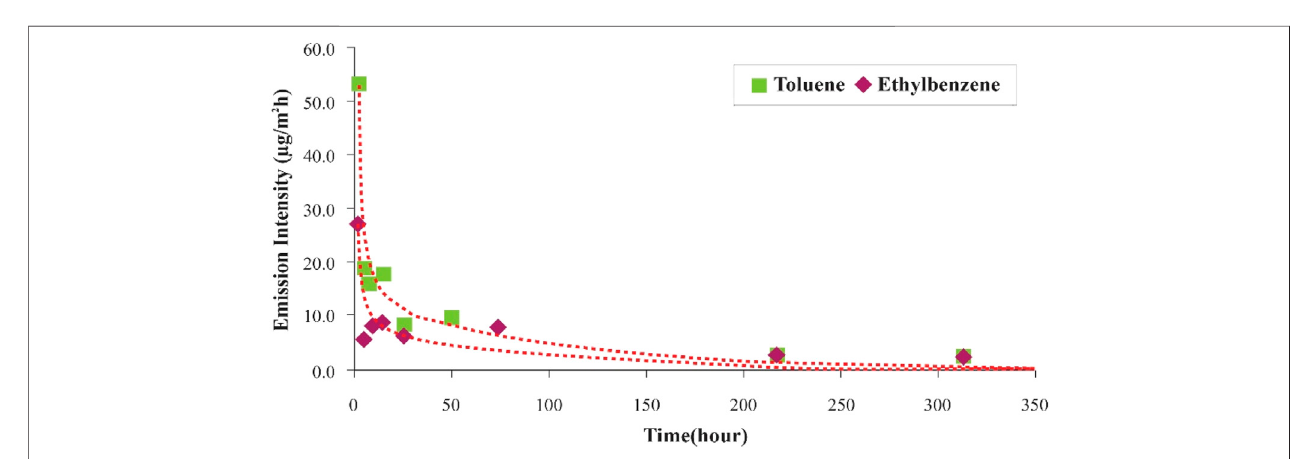
FIGURE 5 | Emission pattern of toluene and ethylbenzene from wallpaper.